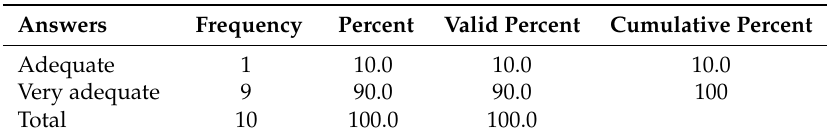
Table 6. Results of the answers of teachers to the question: Do you find this game adequate to primary